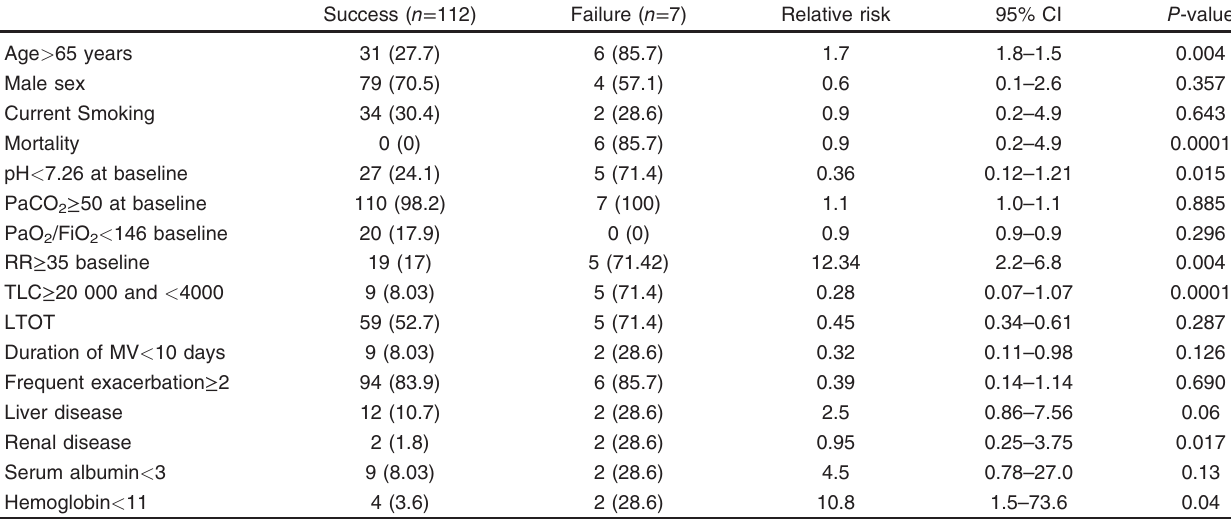
Table 7 Univariate analysis of the different parameters in the success and failure groups